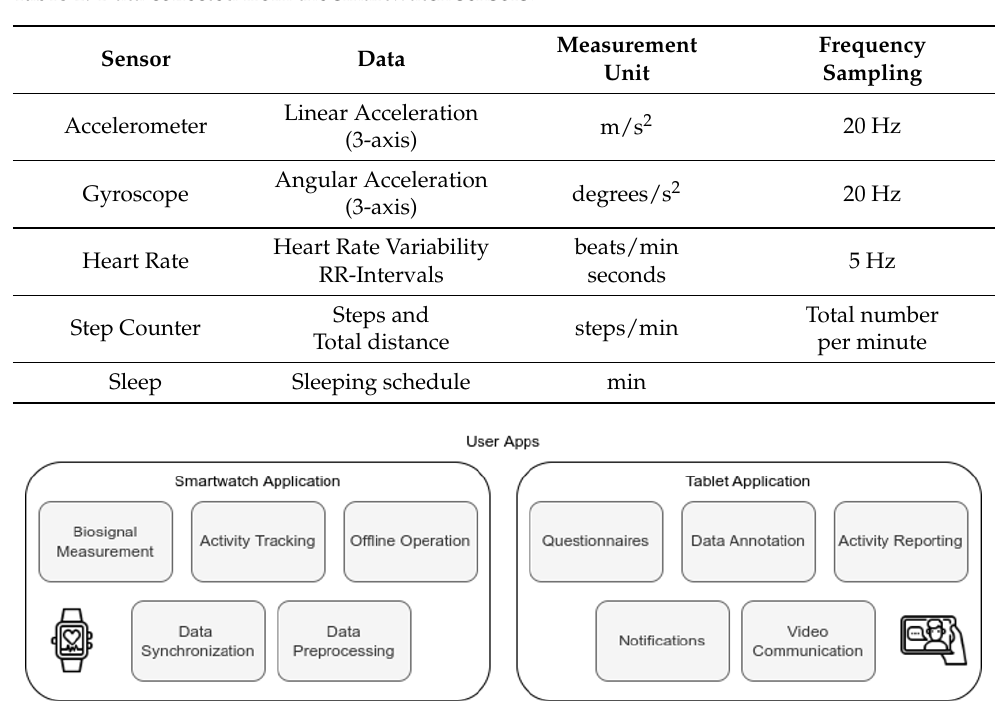
Figure 3. Smartwatch and tablet application